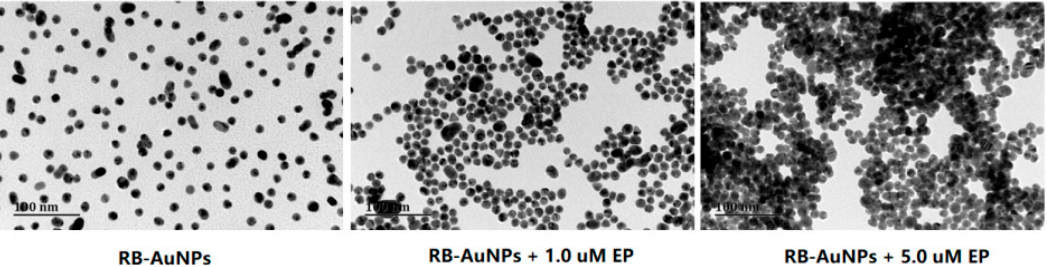
Figure 4. TEM images of RB-AuNPs (3.0 nM) added with various amount of ethoprophos. The scale bar is 100.0 nm.